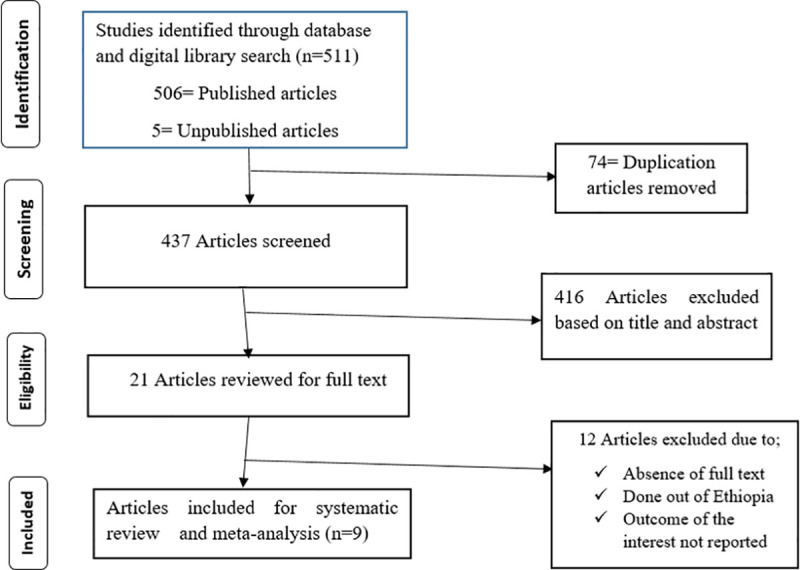
PRISMA flow diagram describes the selection of studies for a systematic review and meta-analysis of short birth spacing and its association with maternal educational status, contraceptive use, and duration of breastfeeding in Ethiopia, 2020.